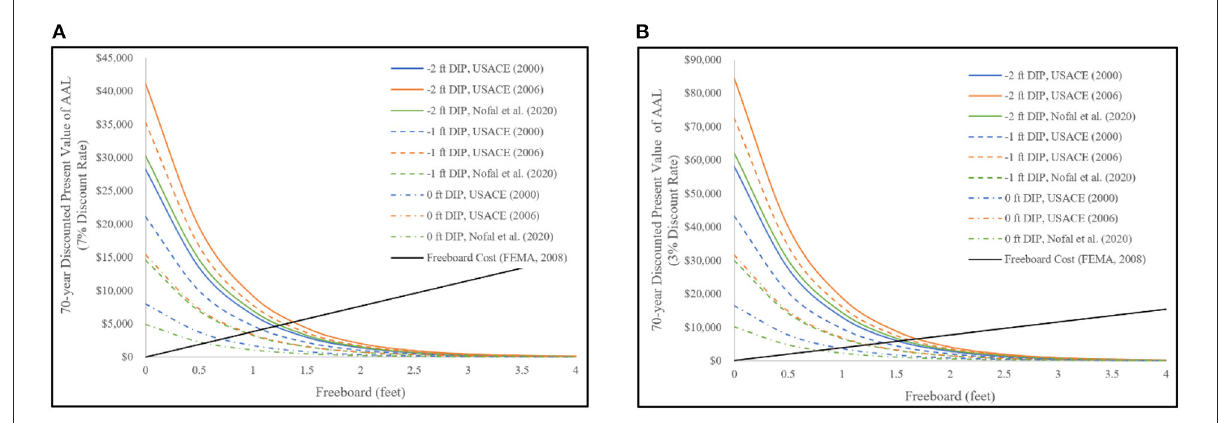
FIGURE3 Variability of discounted present value of AAL with freeboard and damage initiation point of different DDF functions, for a 70-year expected building life using a (A) 7% discount rate, (B) 3% discount rate.